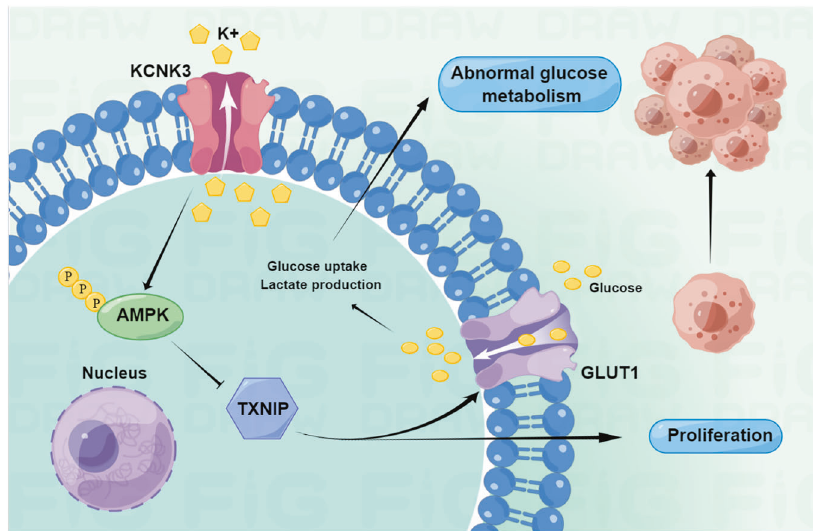
Fig. 7 Schematic representation of the proposed mechanism of KCNK3 in LUAD cells. KCNK3 may regulate proliferation and glucose metabolism via AMPK-TXNIP signaling pathway in LUAD